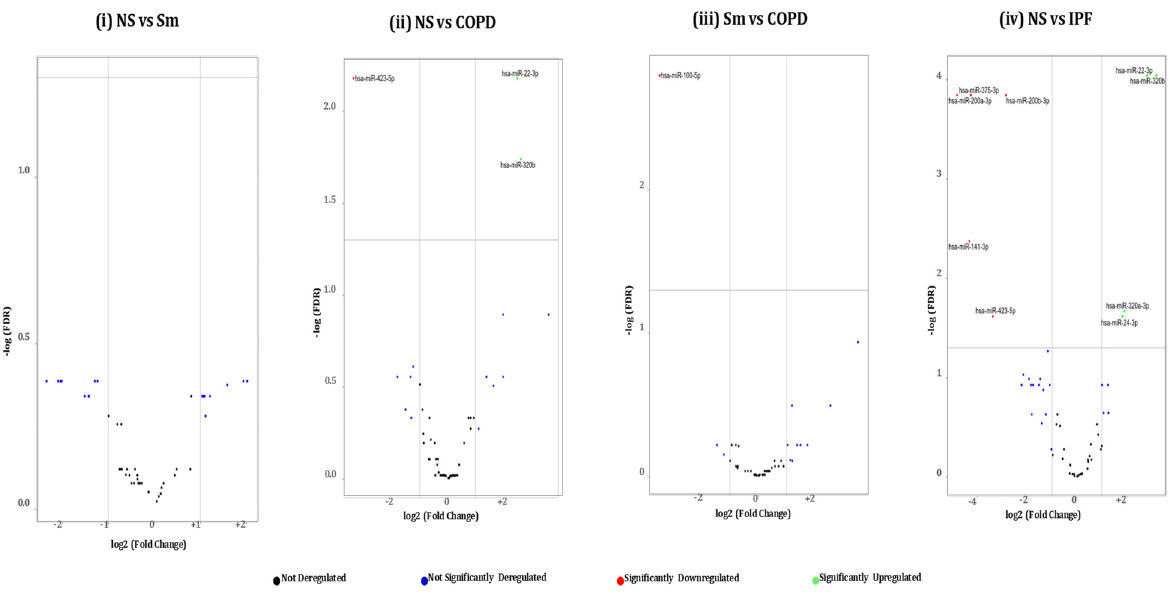
Figure 4 . Volcano plots showing number and distribution of miRNAs from BALF ‐ derived exosomes. Volcano plots showing the relation between − log(FDR) (y ‐ axis) vs. log2 (fold change) (x ‐ axis) in the differentially expressed miRNAs amongst BALF exosomes derived from ( i ) healthy non ‐ smokers (NS) vs. healthy cigarette smokers (Sm), ( ii ) healthy non ‐ smokers (NS) vs. COPD patients (COPD), ( iii ) healthy cigarette smokers (Sm) vs. COPD patients, and ( iv ) healthy non ‐ smokers (NS) and IPF patients (IPF).